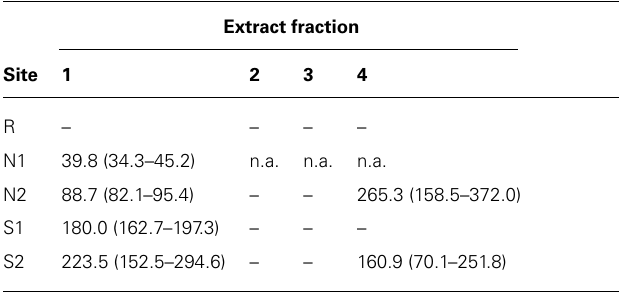
Table 3 | Cytotoxicity EC 50 estimates for HepG2 cells exposed to each extract fraction for all surveyed sediment samples (in mg SEQ/mL). Extract fraction